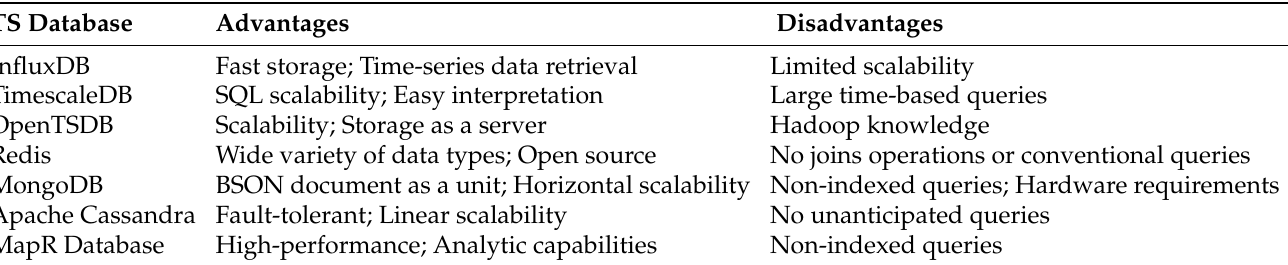
Table 2. Time-series databases